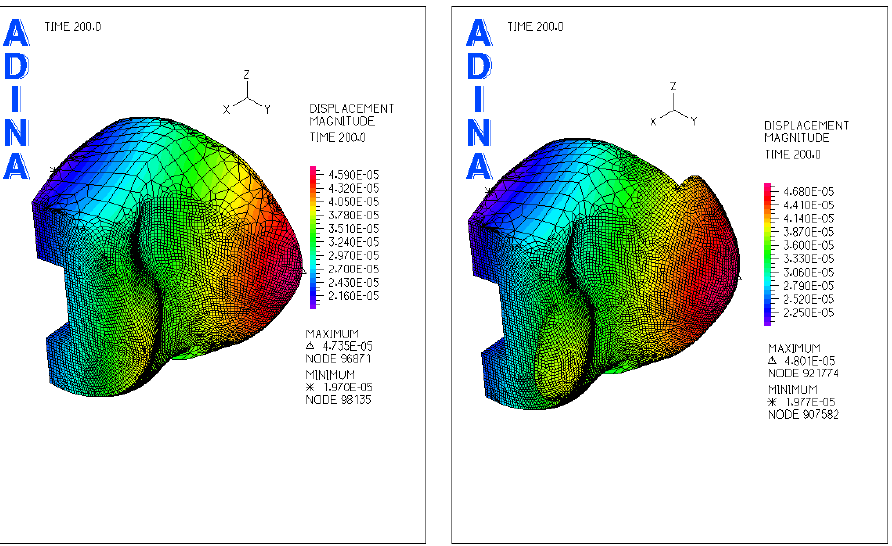
Figure 3. Band plot of the displacement magnitude (m) over the ceramic restorations for the two models, inlay ( left ) and onlay ( right ), with non-matching color scales.